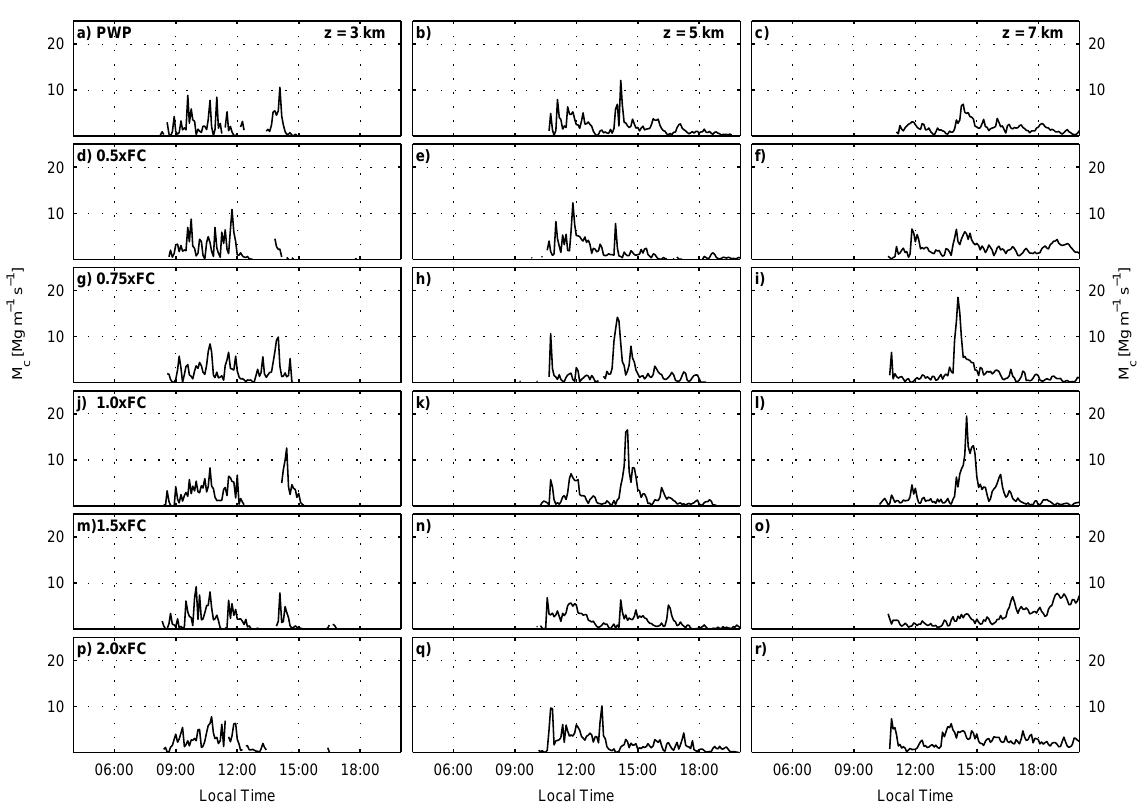
Figure 9. Convective mass flux at 3, 5 and 7kma.g.l. for cases PWP, 0.5 × FC, 0.75 × FC, 1.0 × FC, 1.5 × FC and 2.0 × FC on 17 July 2012.